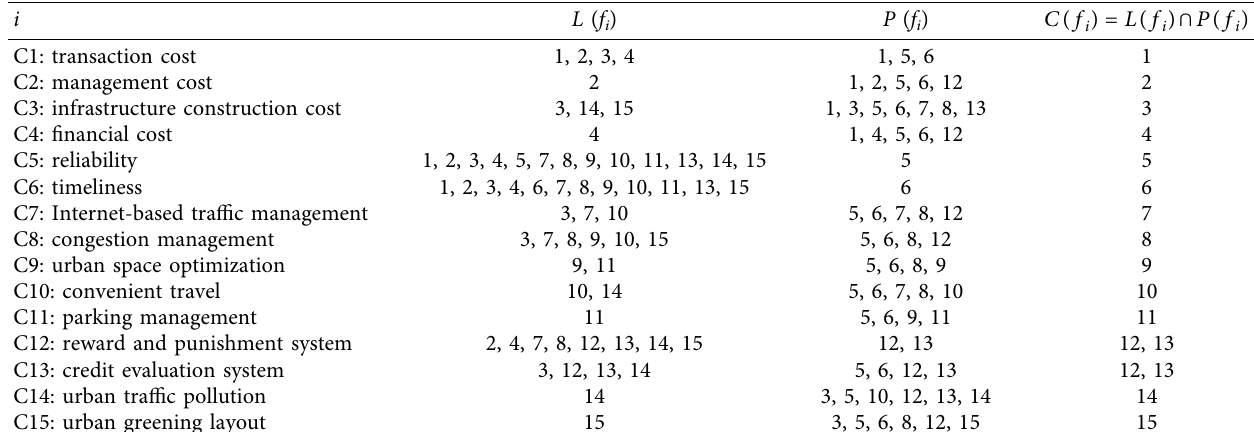
Table 8: First-level decomposition structure.